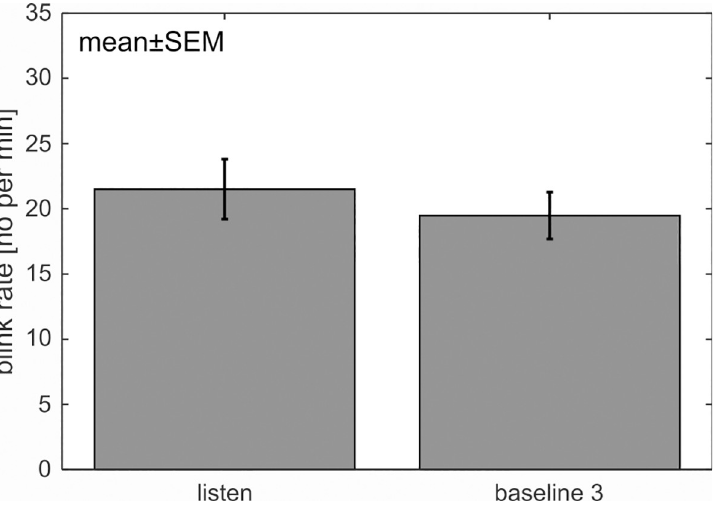
Fig 7. No influence of auditory input on the blink rate. Participants listened to the easy ‘Add 1’ task, where one number was skipped. This number had to be reported afterwards. Blink rate between “listen” and “baseline 3” was not significantly different from each